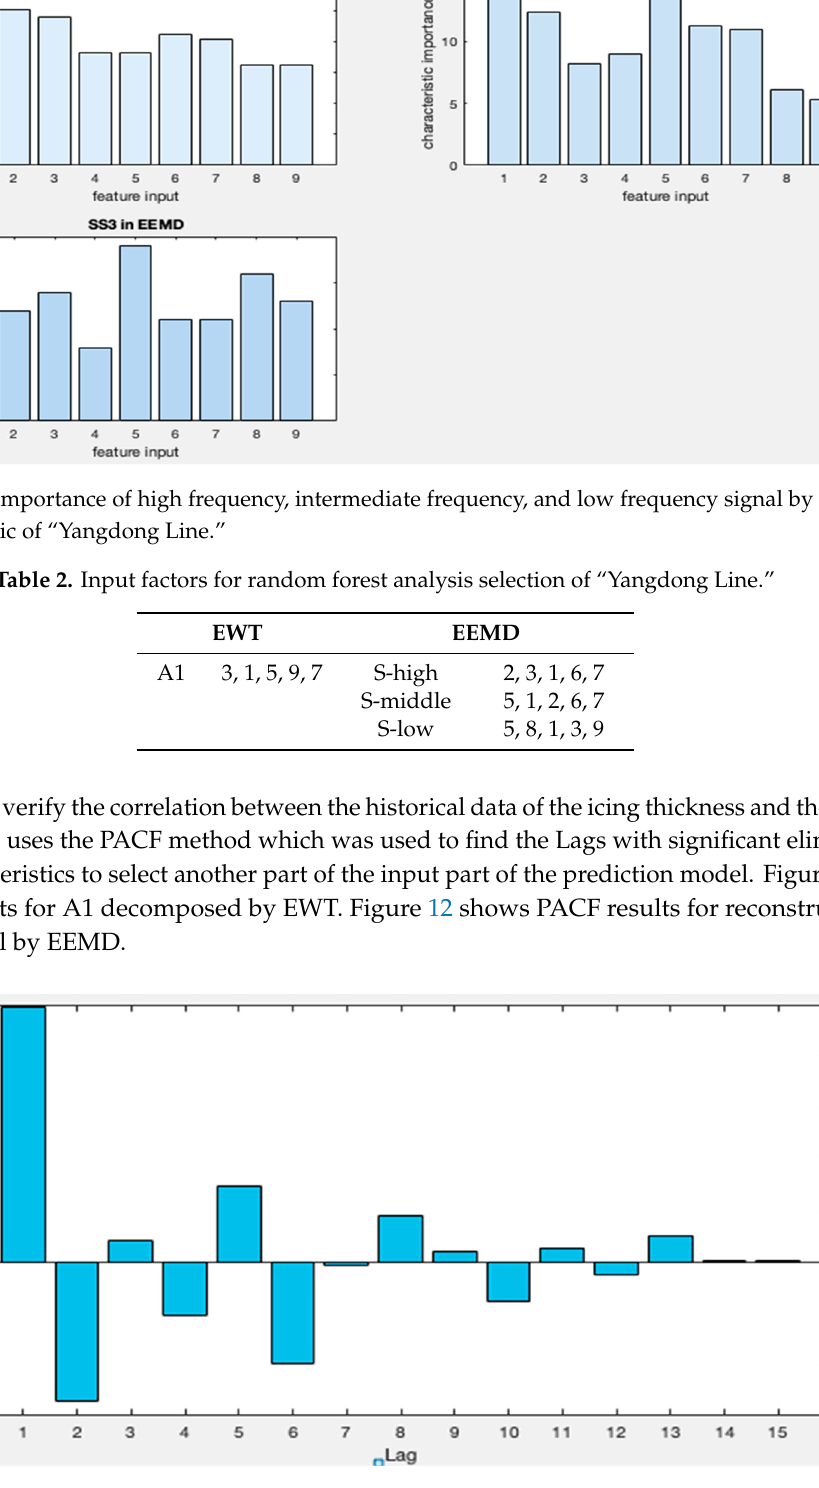
Figure 9. Importance of A1 signal by EWT characteristic of “Yangdong Line.”